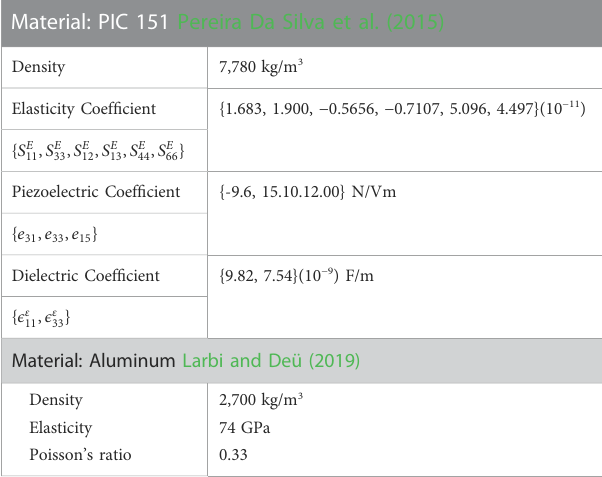
TABLE 1 Material properties for the cantilever beam and piezoelectric ceramic patch.